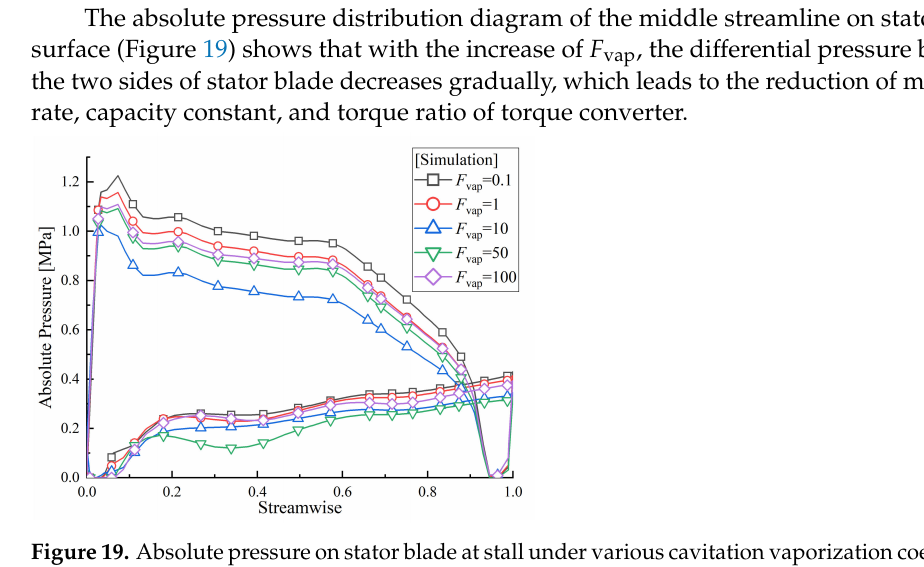
Figure 19. Absolute pressure on stator blade at stall under various cavitation vaporization coefficients.